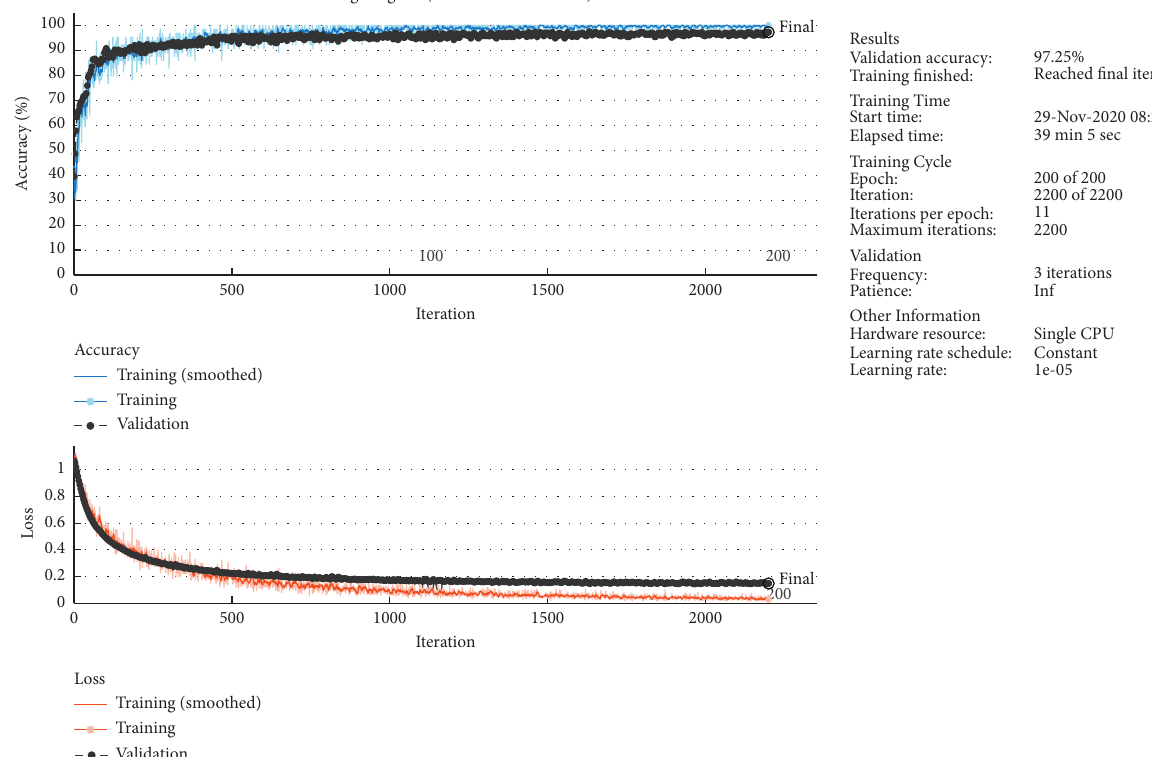
Figure 4: Accuracy and loss measurements for convolutional neural networks used for training and validation